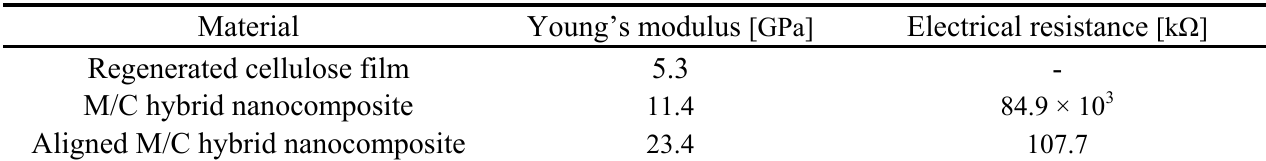
Table 2. Mechanical and electrical properties of M/C hybrid nanocomposite compared with that of regenerated cellulose